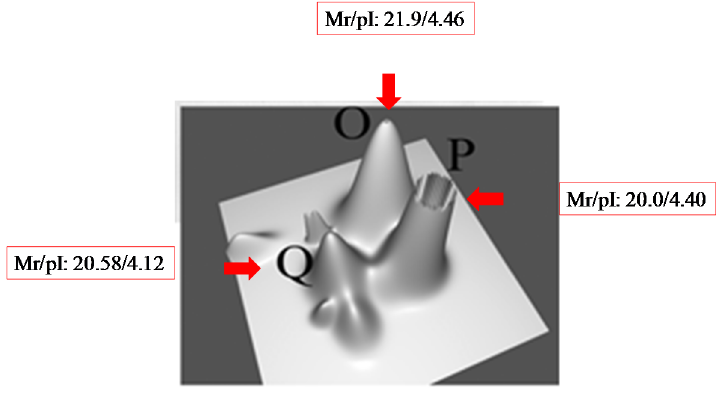
Figure 3. The three main isoforms of β -lactoglobulin, detected by two-dimensional electrophoresis. Adapted from [38].